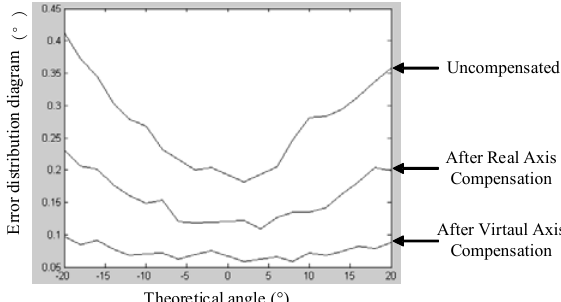
Fig. 7. A-axis deflection error distribution